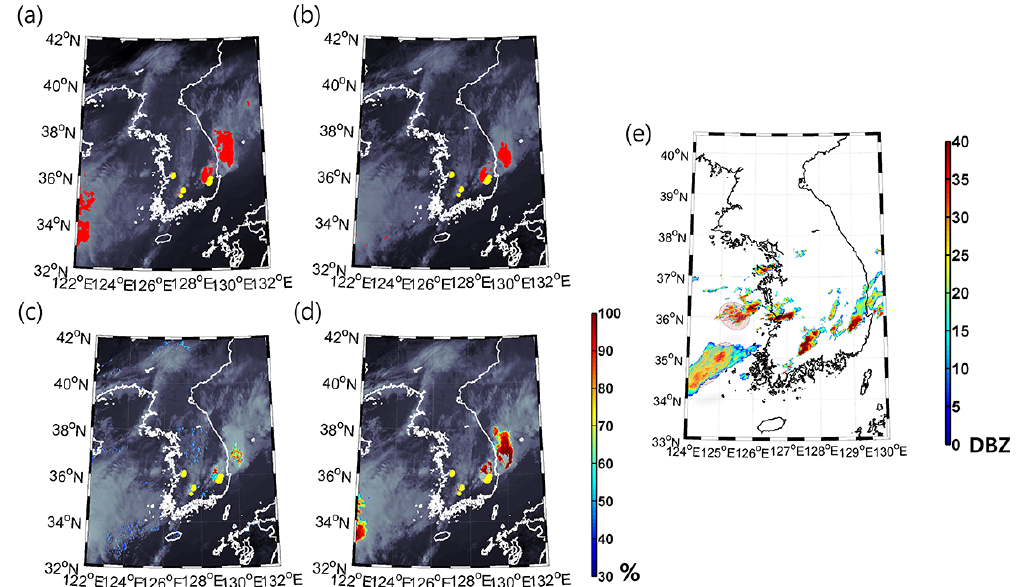
Figure 11. Deterministic CI detection map derived by DT, RF, probabilistic RF, and LR on 6 July 2016 at 05:30 (UTC): (a) DT, (b) RF, (c) probabilistic RF, and (d) LR 40min before CI occurrence. Panel (e) is the 1.5km radar CAPPI image at 06:10 (UTC). While predicted CI is in red, the locations of lightning occurrences at 06:10 (UTC) are presented in yellow dots. The radar echoes above 35dBZ beyond the effective radius of radar are shaded with red hatching.